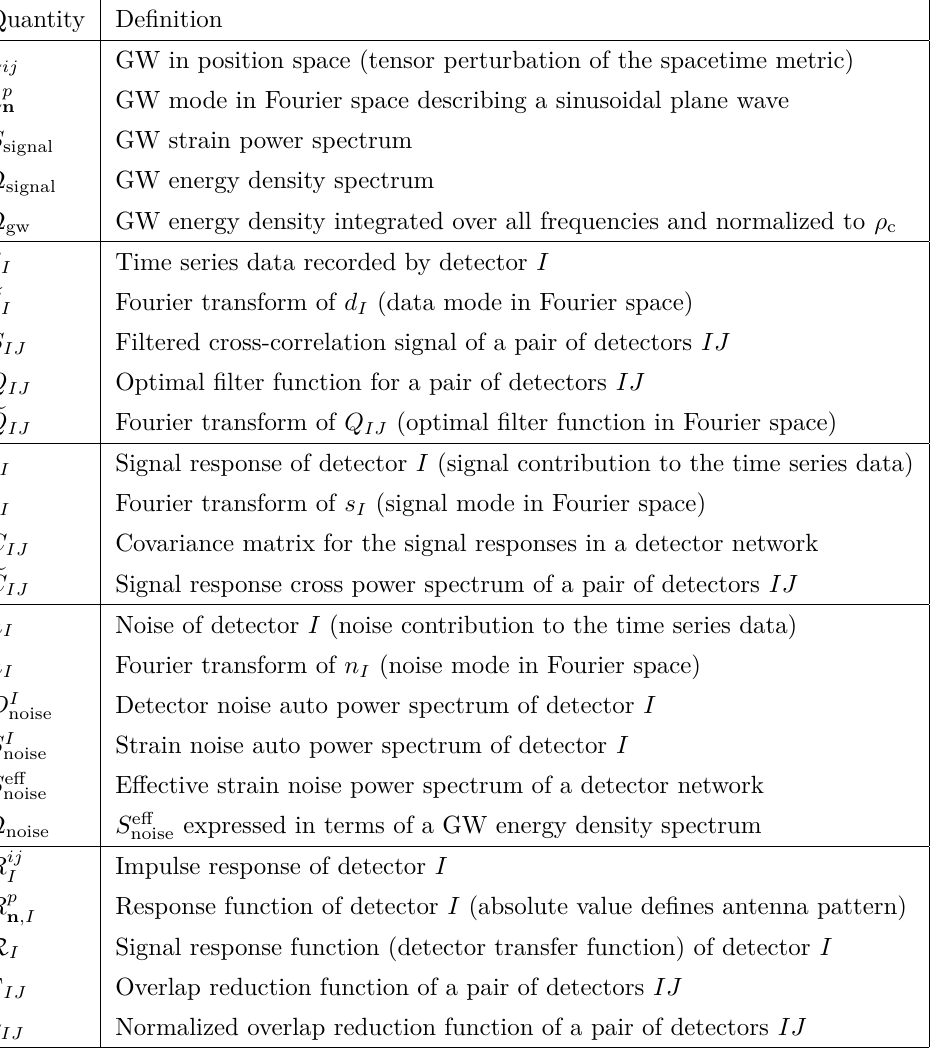
Table 2 . Overview of different quantities playing a role in this